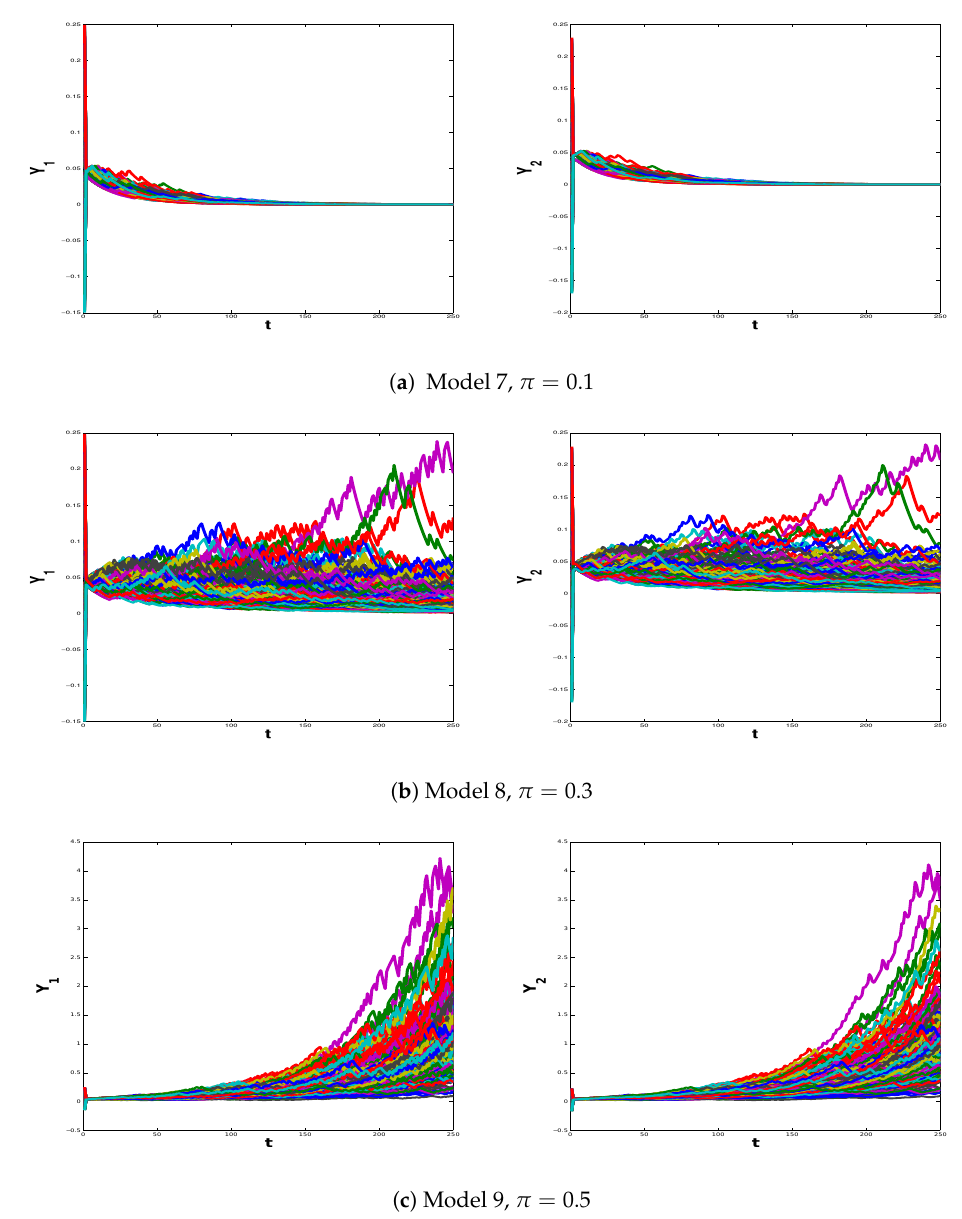
Figure 3. Simulated paths represented by different colors from models 7–9 for different set of histories over a n = 250 period using m = 200 simulated paths. The parameters are those from Table 1 and the probability to be in the explosive regime 2 is equal to π